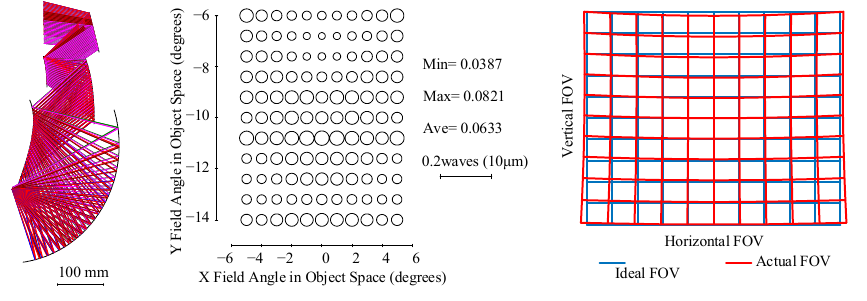
Figure 7. System design after optimization.